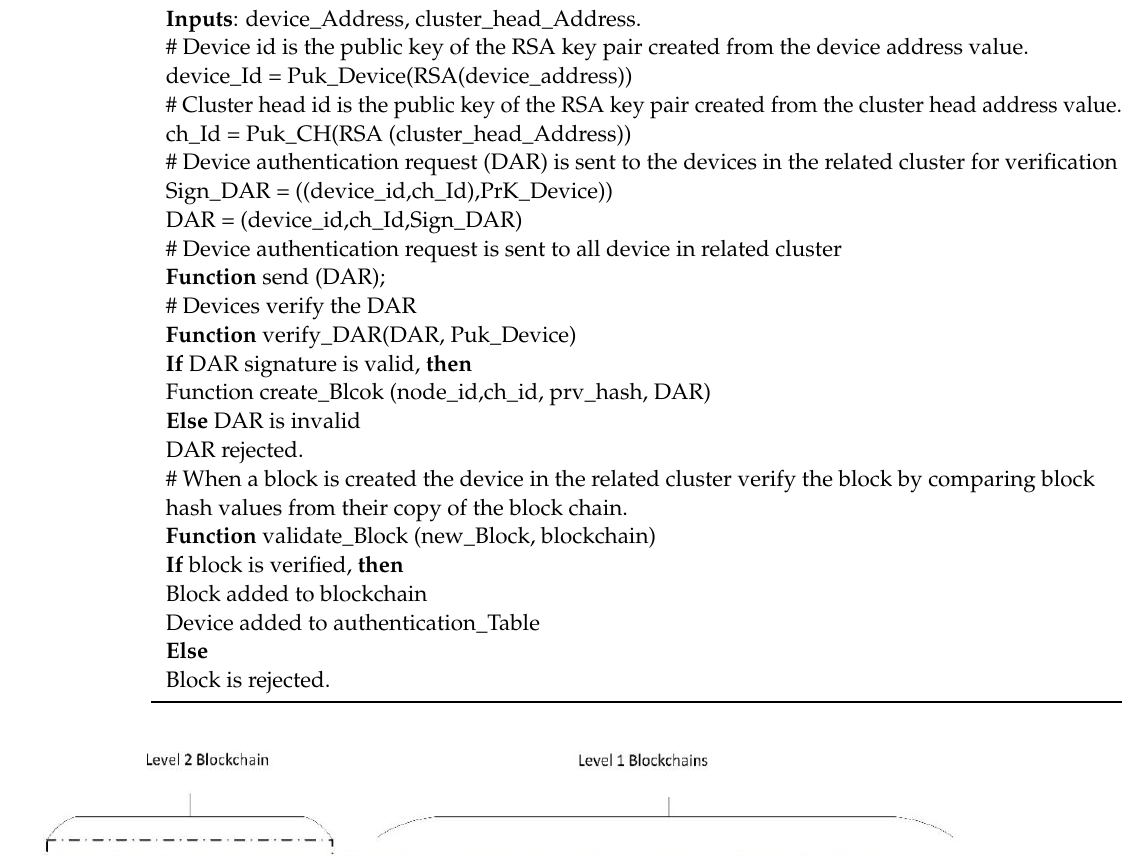
Algorithm 1 : Authentication chains algorithm.